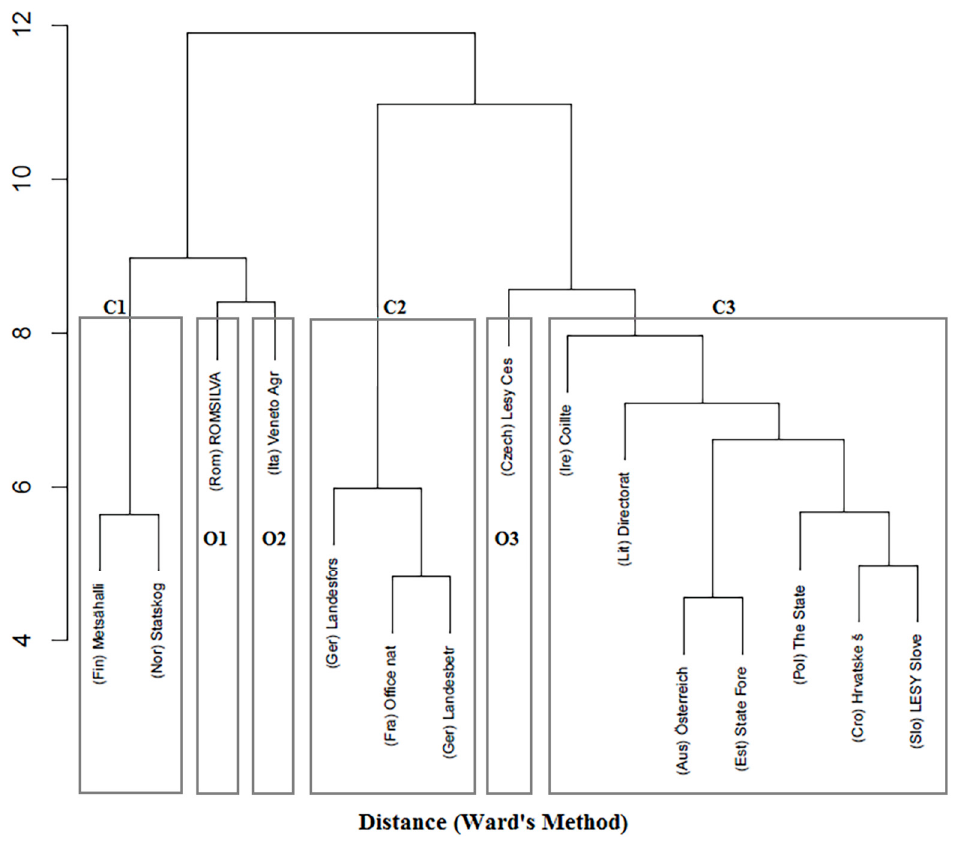
Figure 4. Cluster analysis of SFMOs.